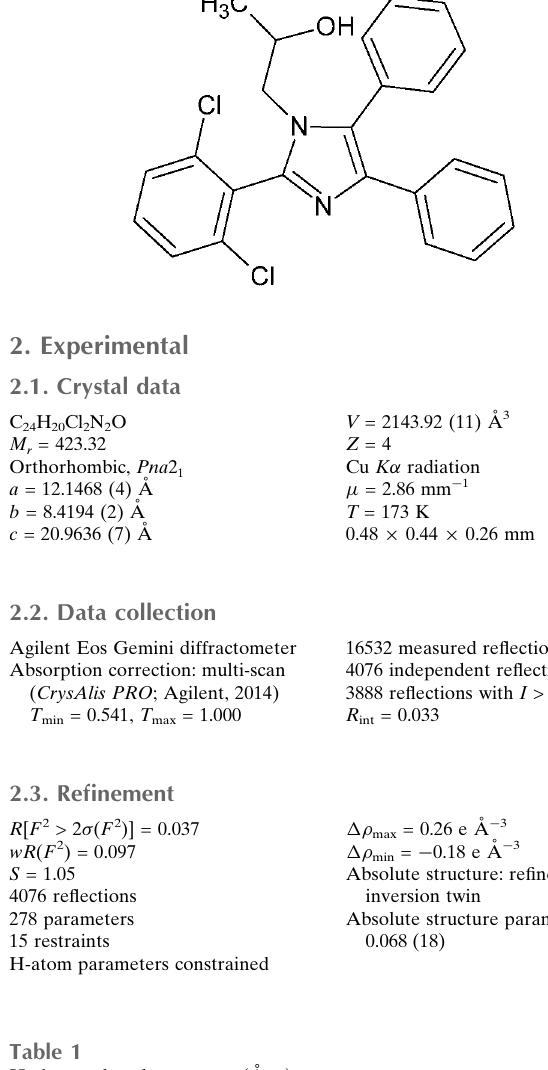
Hydrogen-bond geometry (A˚ , (cid:2) ). Cg 3 is the centroid of the C7–C12 benzene